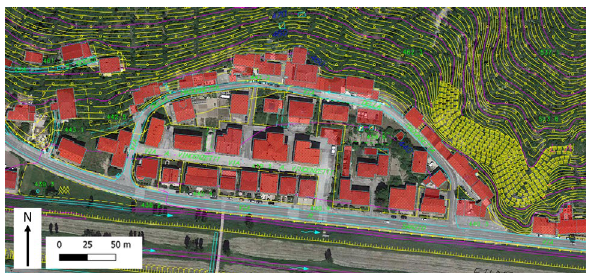
Figure 1. Site plan of the area of interest. Contour lines are shown in yellow.